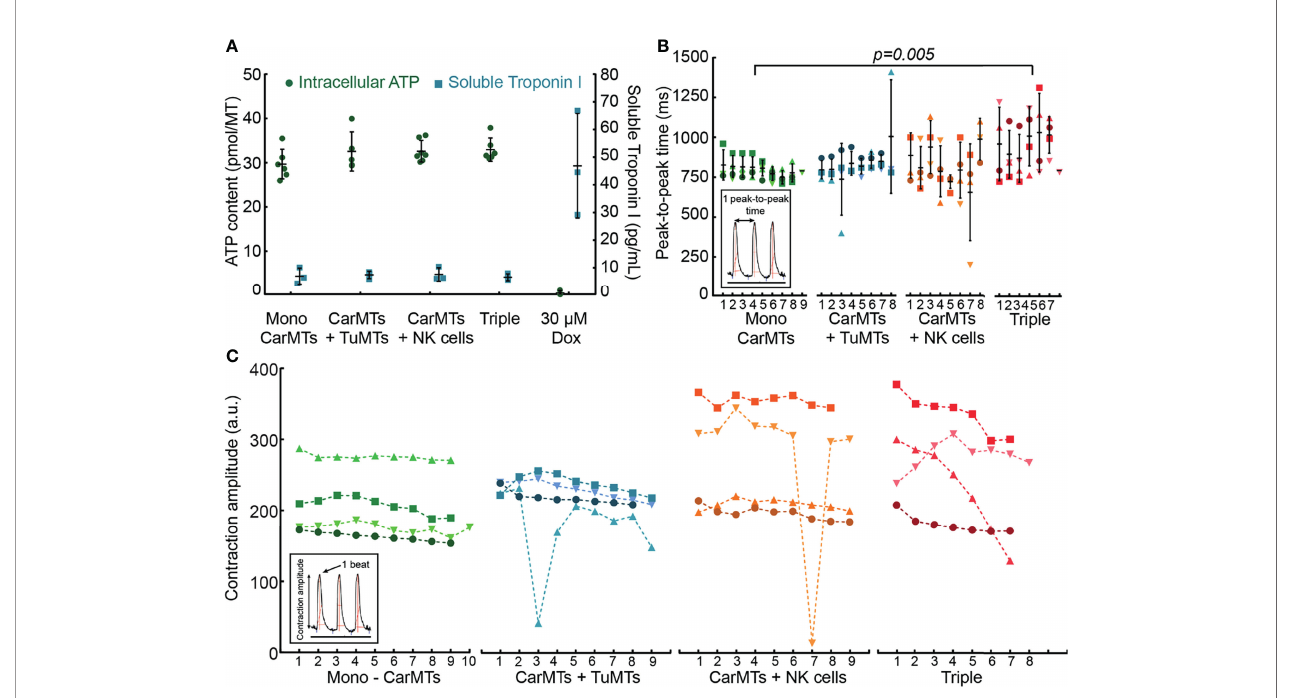
FIGURE 6 | (A) ATP-contents of CarMTs (n = 6) indicating viability and average soluble Troponin I, produced by individual CarMTs under different culture conditions (n = 3) (Mono, mono-culture; Triple, triple culture; Dox: Doxorubicin hydrochloride). (B) Changes in beating patterns of CarMTs under different conditions, represented as peak-to-peak time between contractions (ms). The fi gure shows exemplary patterns of four CarMTs per culture condition. The numbering on the X-axis indicates the peak-to-peak interval count of individual CarMTs within a 20-seconds recording window (peak-to-peak intervals are shown in the insert graph.). (C) Contraction amplitudes of CarMTs under different culture conditions. The fi gure shows exemplary patterns of four CarMTs per culture condition. The numbering on the X-axis indicates the beat count of individual CarMTs within a 20-second recording window (beat counting is illustrated in the insert graph). For each culture condition, contraction amplitudes of the same CarMT were connected by a dashed line in chronological order. The same color code was applied for the same CarMT in both (B, C)